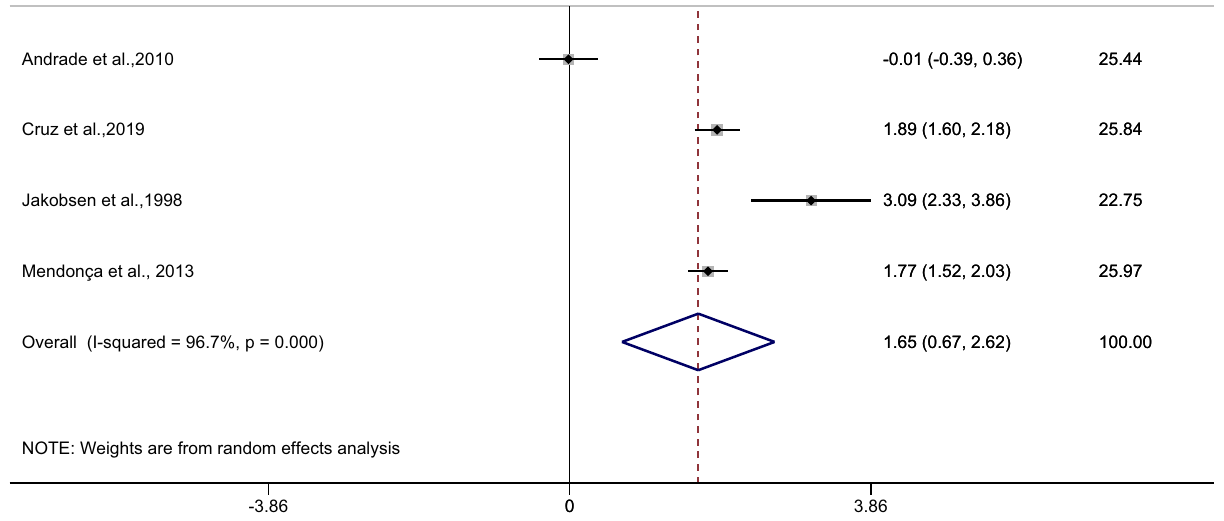
Figure 5. Forest plot demonstrates the difference in the mean CRP level between patients with uncomplicated and asymptomatic malaria. SMD, standard mean difference; CI, confidence